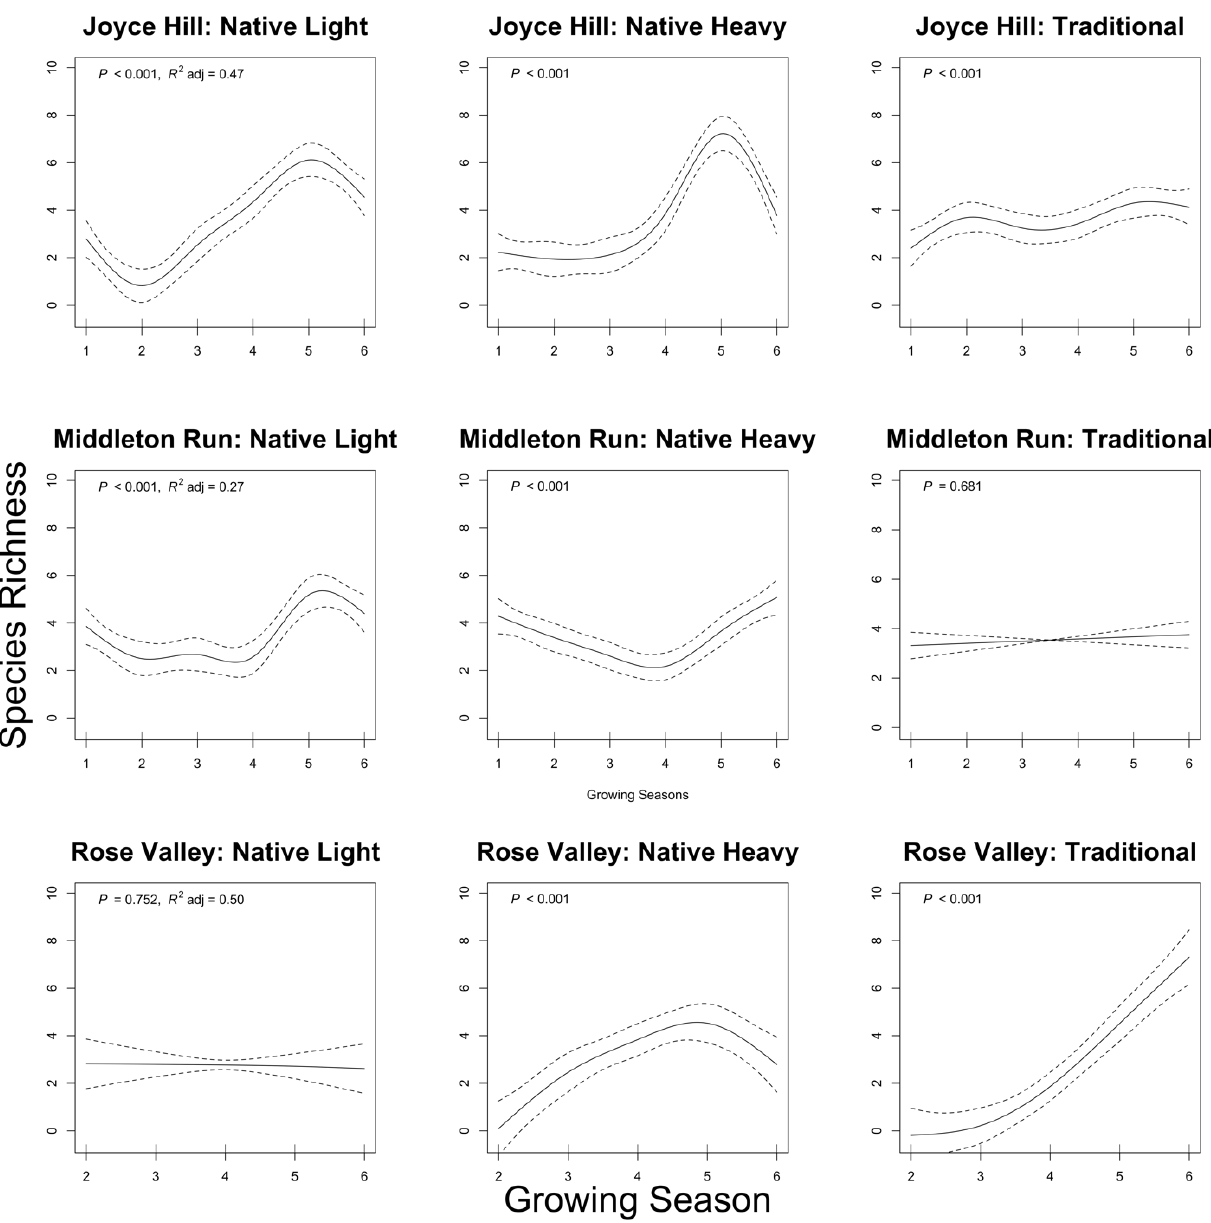
Figure 3. Species richness over growing seasons for three seed mix treatments. Plot based on results from a term of a generalized additive model. Dotted lines represent two standard errors. Treatments within a single site are displayed within a single row. Adjusted R 2 values for seed treatment by growing season smooths are displayed in the first panel of each row.